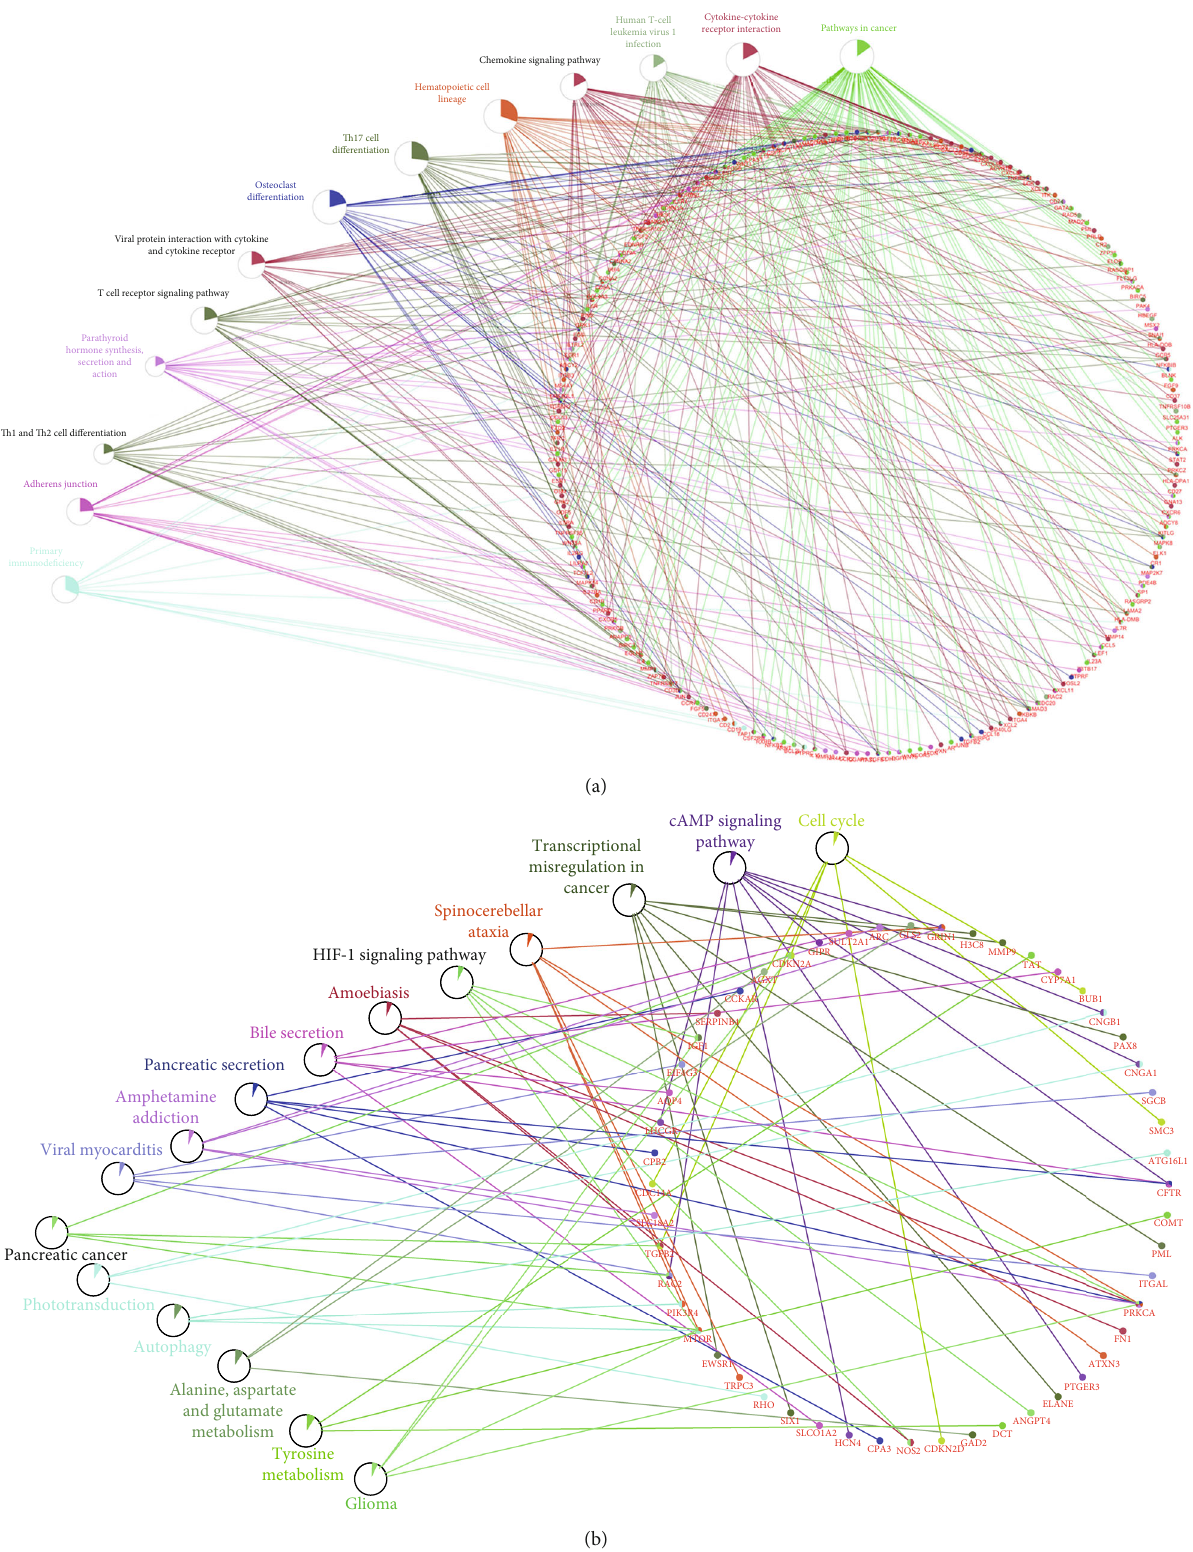
Figure 3: KEGG pathway analysis of DEG. The setting conditions were as follows: P < 0 : 05 , genecount ≥ 3 . (a) RA and No-RA groups. (b) M-RA and F-RA